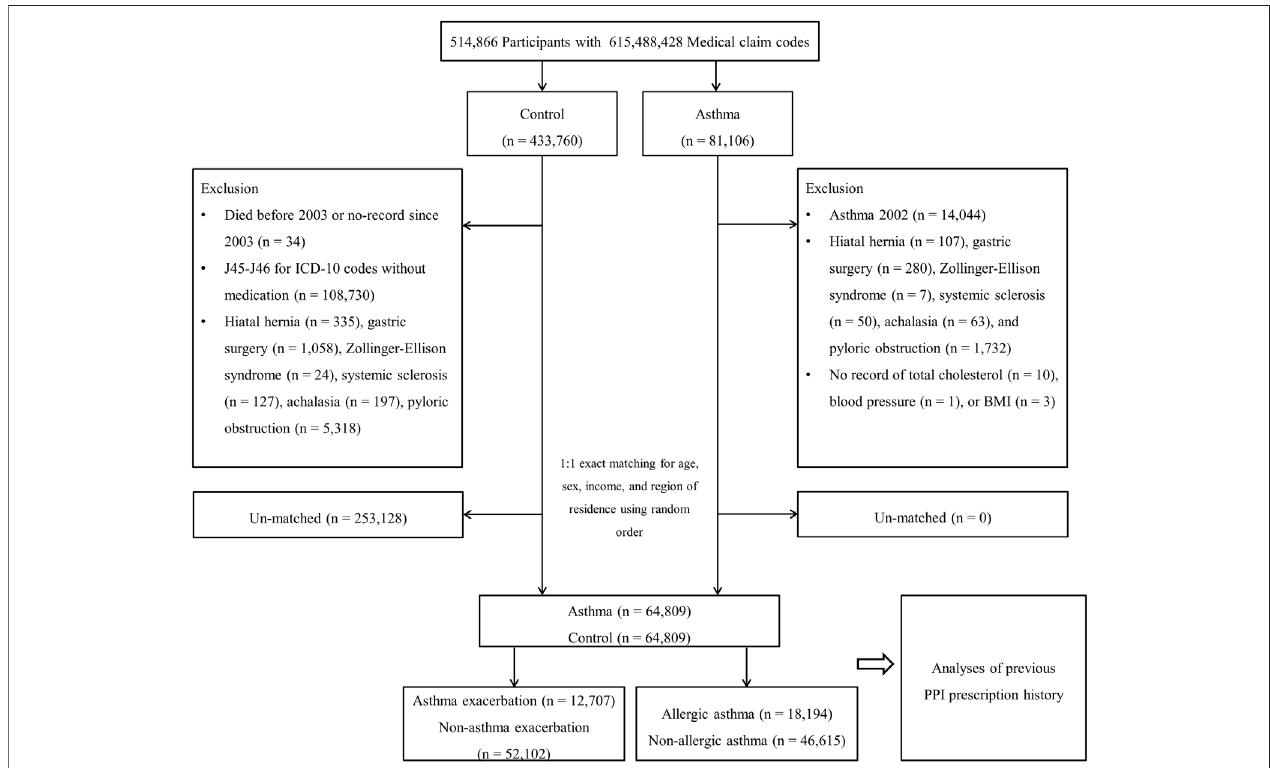
FIGURE 1 | A schematic illustration of the participant selection process that was used in the present study. Of 514,866 participants, 64,809 asthma participants were matched with the same number of control participants for age, sex, income, and region of residence.